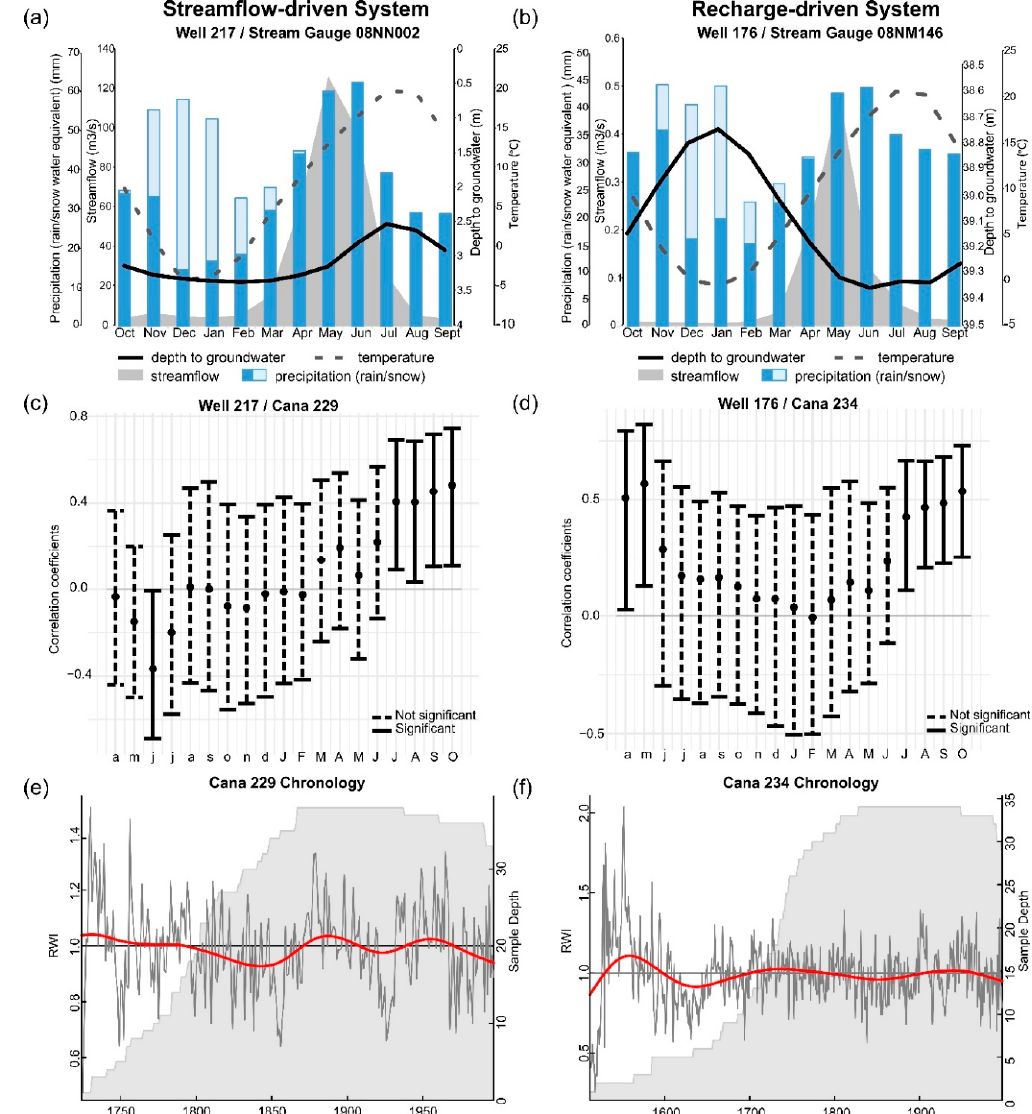
Figure 4. Example groundwater (black solid line) and streamflow (shaded grey area) hydrographs for ( a ) a streamflow-driven system and b) a recharge-driven system. Temperature (grey dashed line) and precipitation (blue/light blue bars distinguishing rain from snow) are also shown in a) and ( b ). Corresponding tree ring width/depth to groundwater level correlation graphs are shown for ( c ) a streamflow-driven system and ( d ) a recharge-driven system. The standard chronologies produced using dplR are shown for the two sample chronologies which were located near these observations wells: ( e ) Cana 229 and ( f ) Cana 234, with the grey solid line indicating annual ring width indices, grey shading indicating the sample depth through time, and the solid red line showing a 20-year smoothing spline.